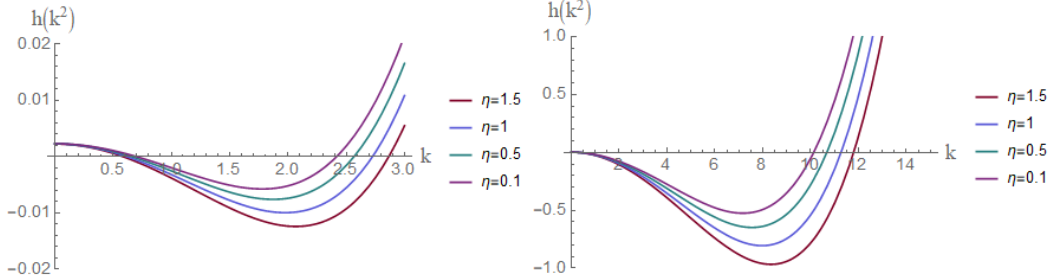
Figure 6. Plots of h ( k 2 ) as a function of the wavenumber k for different values of the fear level η ; in the left panel it is γ 21 = 0.02, in the right panel it is γ 21 = 0.08. Moreover, α = 2.5, r = 0.18, γ 11 = 0.01, γ 22 = 0.1, γ 12 = 0.01 and other parameter values as in Table 1.